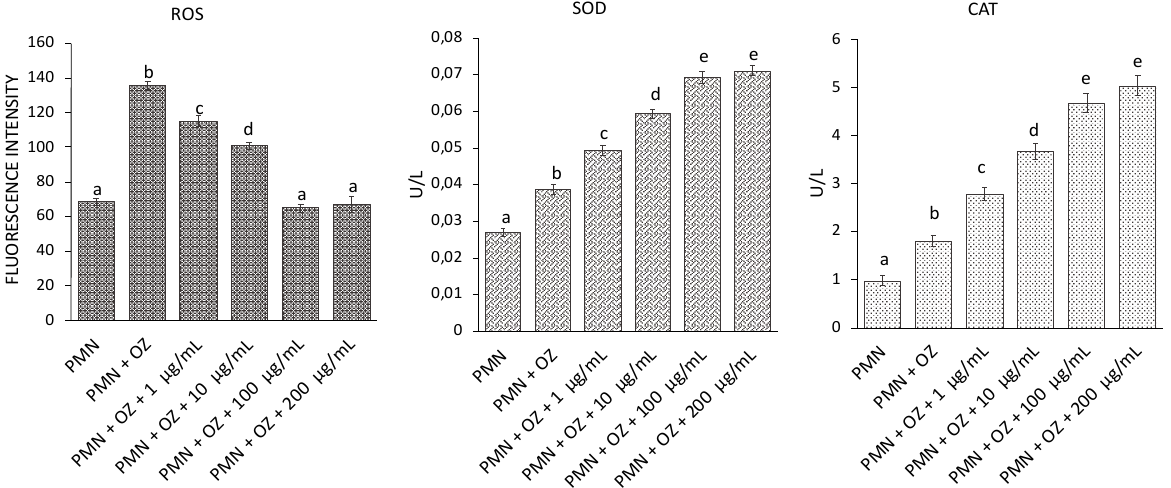
Figure 7. ROS generation and SOD and CAT activities in PMNs treated with EO of C. aurantium ‘Crispifolia’ at different concentrations ( x -axis) with or without OZ. Data were presented as mean and standard error and they were analyzed with a paired t-test. Bars not accompanied by the same letter were significantly different at p < 0.05.